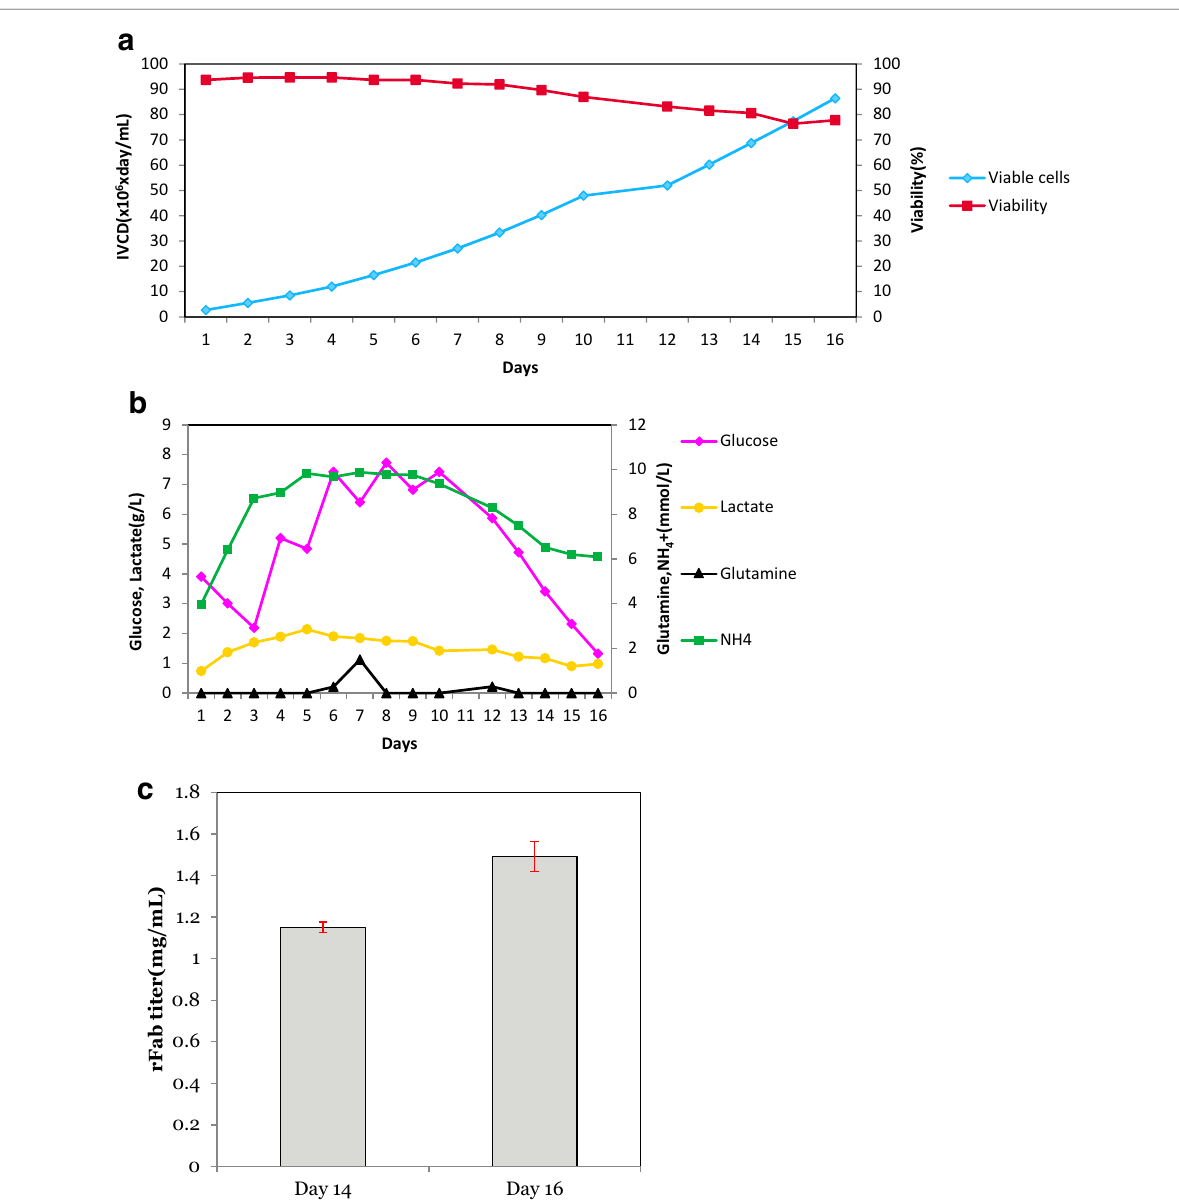
presented in this study suggests that shifting the tem- which ultimately improved the cell growth, viability, and The accumulation of lactate and ammonium in cul- ture has been shown to significantly impact the qual- ity of recombinant proteins; for example, affecting the